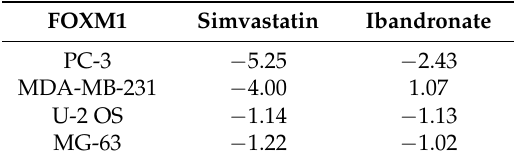
Table 4. Fold downregulation of forkhead box M1 FOXM1